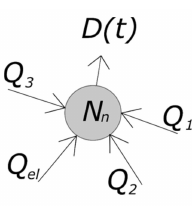
Figure 1. Generic node of a water distribution system